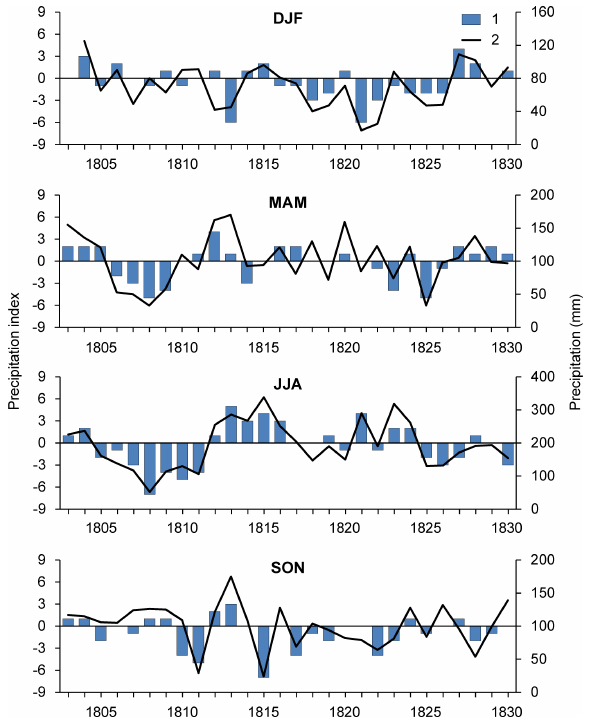
Figure 11. Fluctuations in weighted seasonal temperature indices in Buchlovice (1) and in mean seasonal temperatures in Brno (2) during the 1803–1830 period.